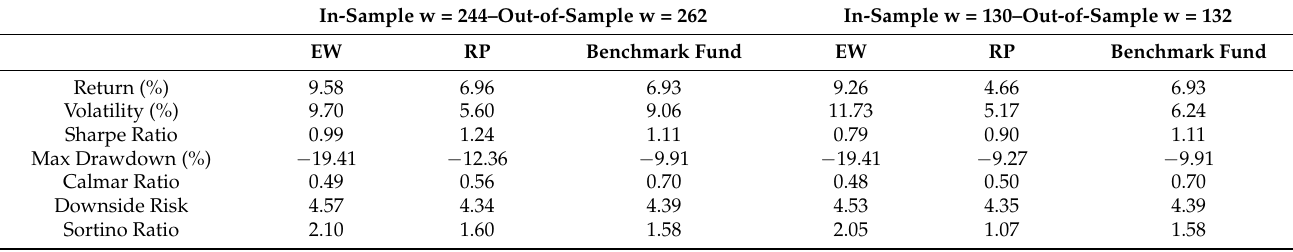
Table 8. The performance of the Combined Portfolios.